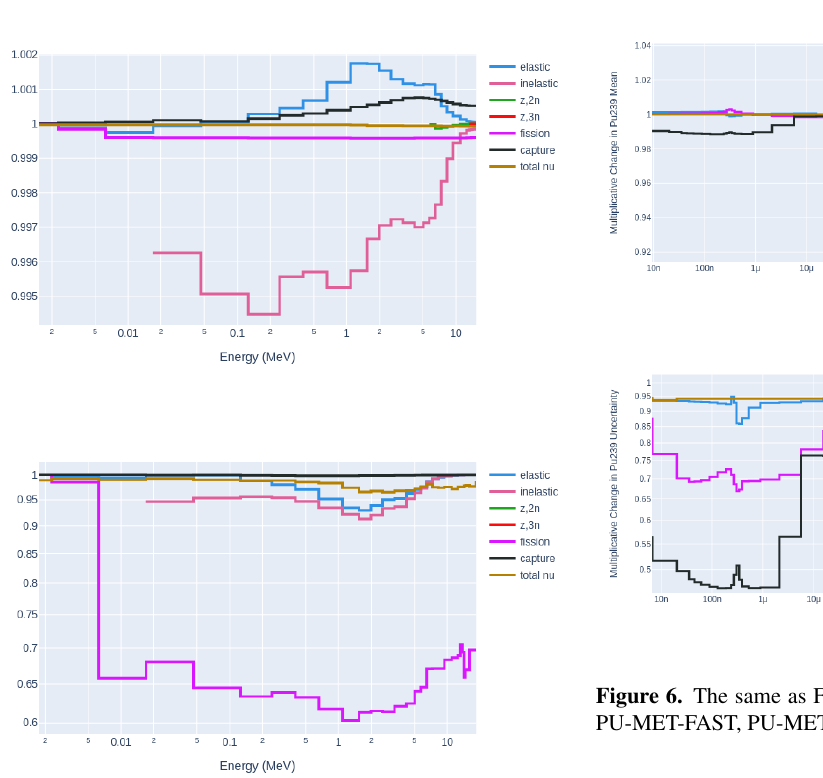
Figure 5. (Top) The % change of adjusted mean values as a ratio to ENDF / B-VIII.0 239 Pu nuclear data is shown. (Bottom) The % change of adjusted uncertainties as a ratio to ENDF / B-VIII.0 239 Pu nuclear-data uncertainties is shown. The adjustment was undertaken with respect to k e ff of Jezebel.